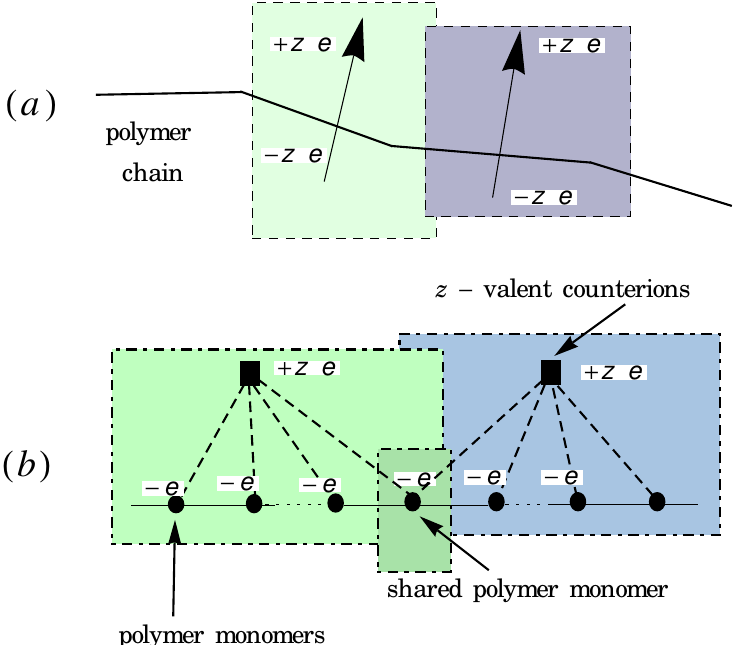
Figure 11. Illustrations of ( a ) associated dipoles formed between condensed multivalent counterions and polymer monomers and ( b ) multivalent counterions sharing polymer monomers. The latter case allows for overcharged chains. The effective charge increases with the number of shared polymer monomers and is a nonlinear function of chain length.